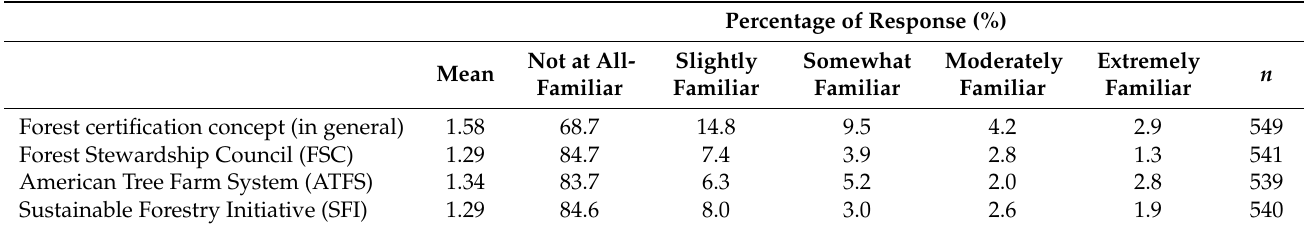
Table 1. Landowners’ familiarity with forest certification